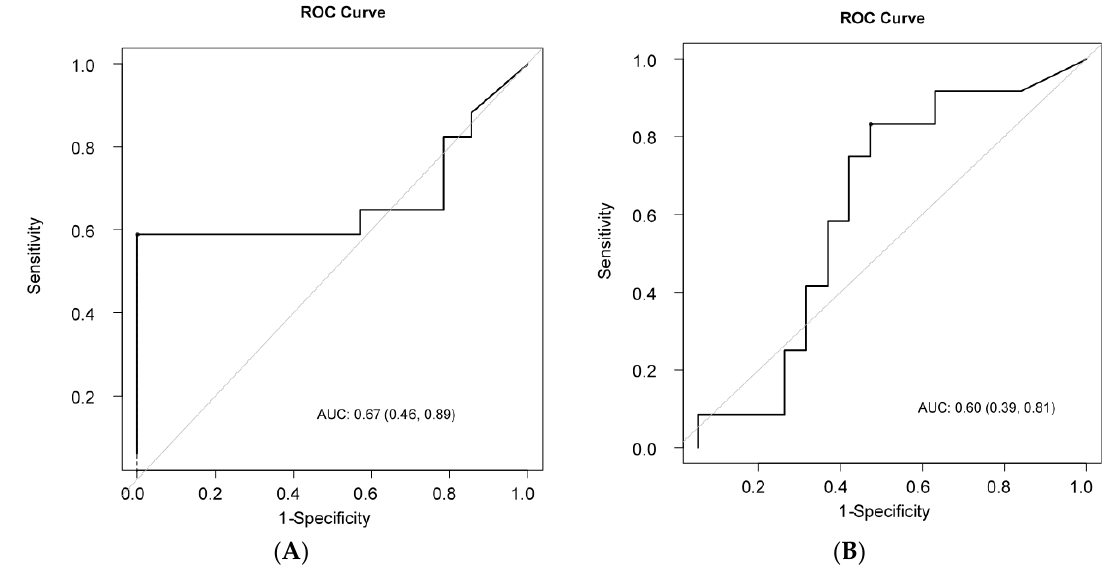
Figure 2. ( A ) Receiver-operating characteristic (ROC) analysis to differentiate LRs from non-LRs. Cut-off Δ (SUV) (%): 28.8%, area under the curve: 0.67; ( B ) ROC analysis to differentiate LSs from non-LSs. Cut-off Δ (SUV) (%): 53.8%, area under the curve: 0.62.